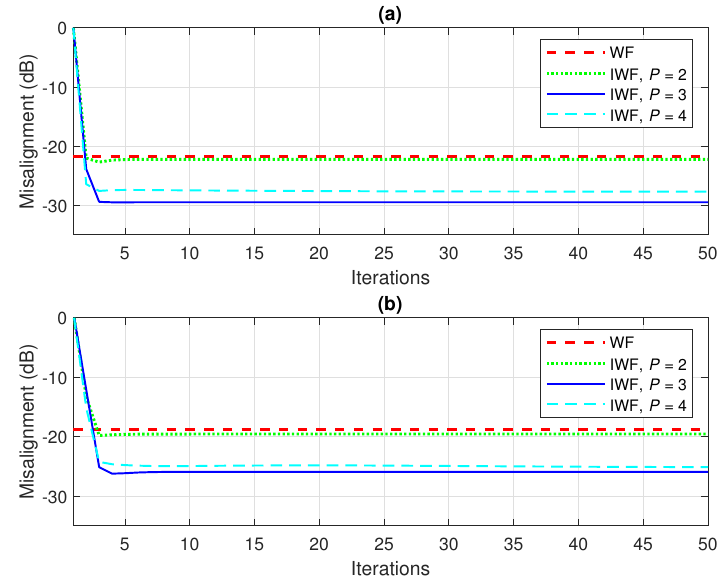
Figure 3. Performance of the conventional Wiener filter (WF) and the iterative Wiener filter (IWF) for the identification of ( a ) the network echo path from Figure 1a and ( b ) the network echo path from Figure 1b. The input signal is an AR(1) process, N = 5000 (available data samples), and SNR = 20 dB. A similar experiment is performed in Figure 4, for the identification of the acoustic echo paths from Figure 1c,d. The other conditions remain the same, i.e., N = 5000 and SNR = 20 dB. As previously indicated in Figure 2c,d, the rank of matrix H is larger for the acoustic impulse responses. Nevertheless, a reasonably small value of P (as compared to L 2 ) can still be used even in such scenarios. The results provided in Figure 4 show that a value of P < L 2 /2 is sufficient for the iterative Wiener filter to achieve the accuracy of the conventional Wiener solution. In addition, a reasonable attenuation of the misalignment is obtained by the iterative algorithm even for a smaller value of its specific parameter, e.g., P < L 2 /3.